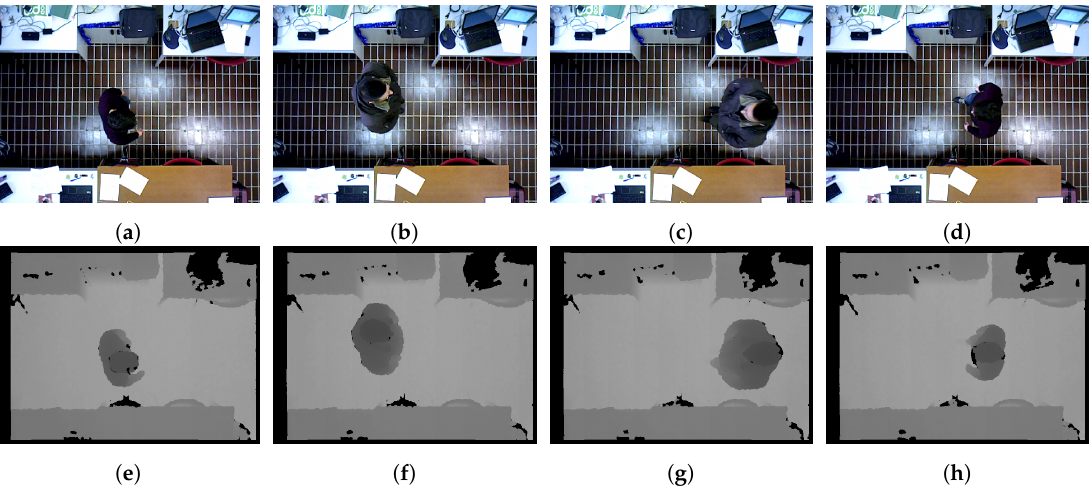
Figure 2. Snapshots of a registration session of the recorded data, in an indoor scenario, with artificial light. People passed under the camera installed on the ceiling. The sequence ( a – e ), ( b – f ) corresponds to the sequence ( d – h ), ( c – g ), respectively, training and testing set of the classes 8–9 for the registration session g003 .